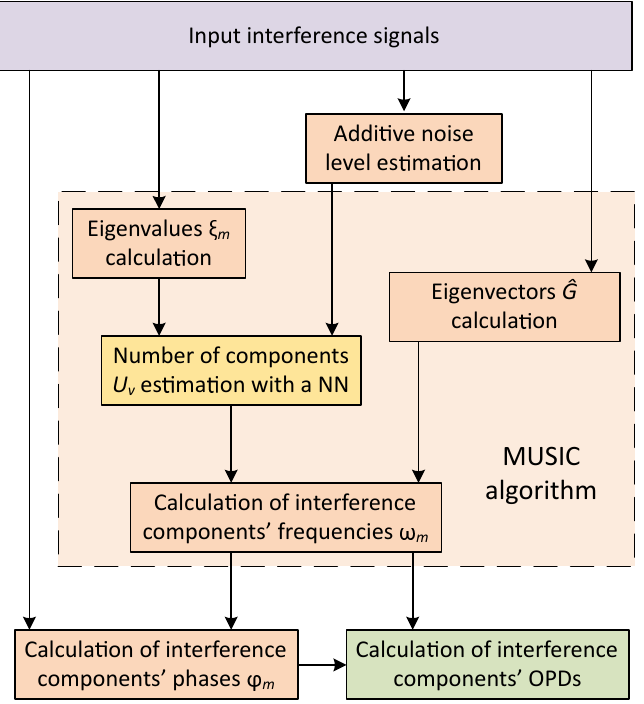
Figure 3. Flowchart of interference-signal